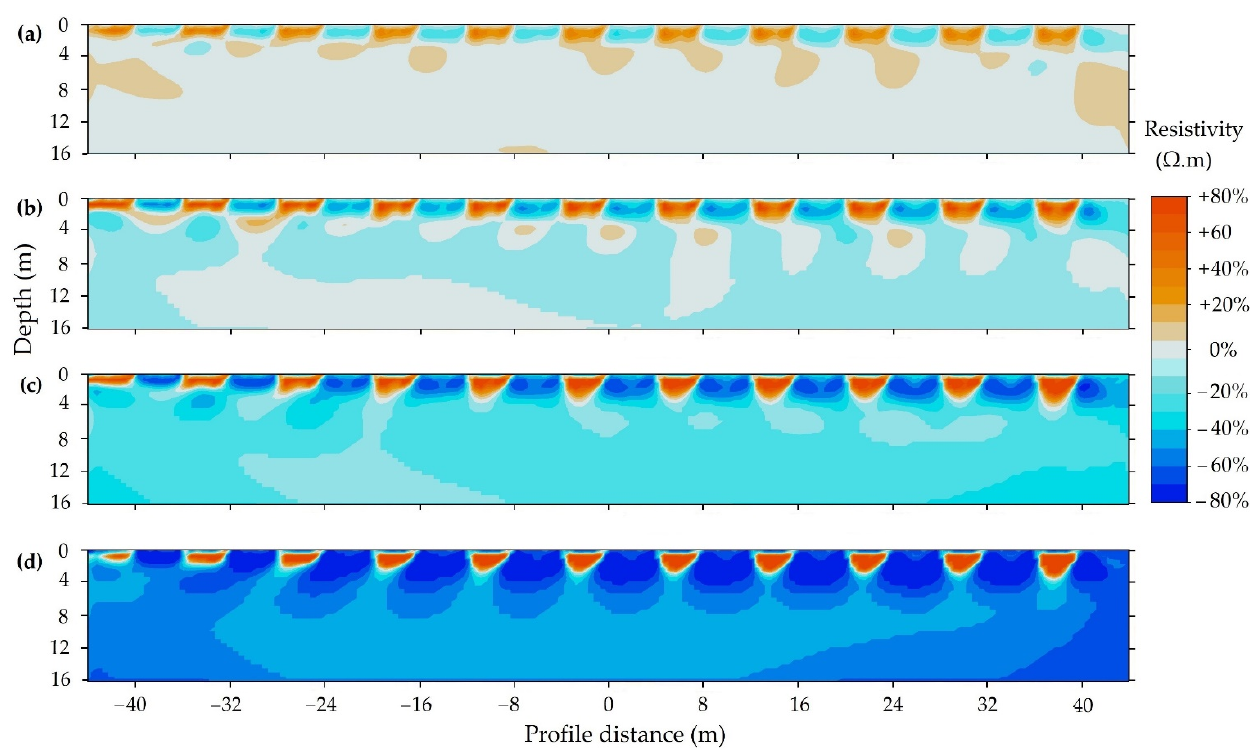
Figure 26. Dipole-dipole (DD) array sensitivity to resistivity perturbations. The inverted model for: ( a ) ±20% perturbation,